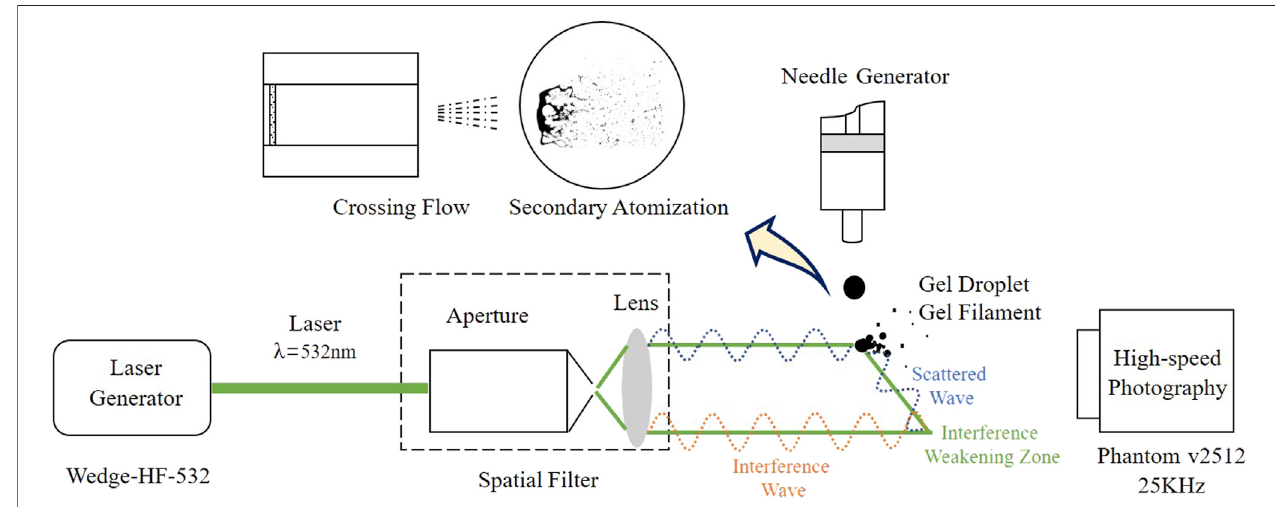
FIGURE 1 | Schematic of the high-speed DIH system for measuring crossing fl ow atomization of gel droplet.